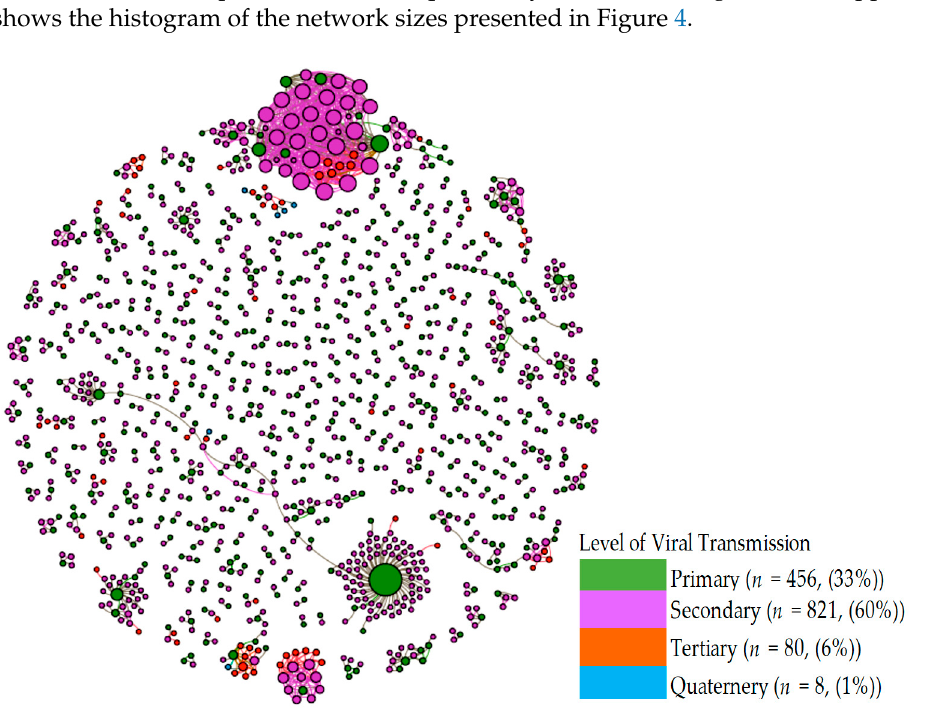
Figure 4. Viral Transmission Level in Viral Transmission Networks (Hokkaido and Kanagawa). Transmission networks of the virus are shown. Green circles represent the primary COVID-19 case, while purple circles represent the secondary cases. Circle size denotes impact (number of infectees). Orange and blue circles represent the tertiary and quaternary infectees. Most of the networks consist of only two individuals.